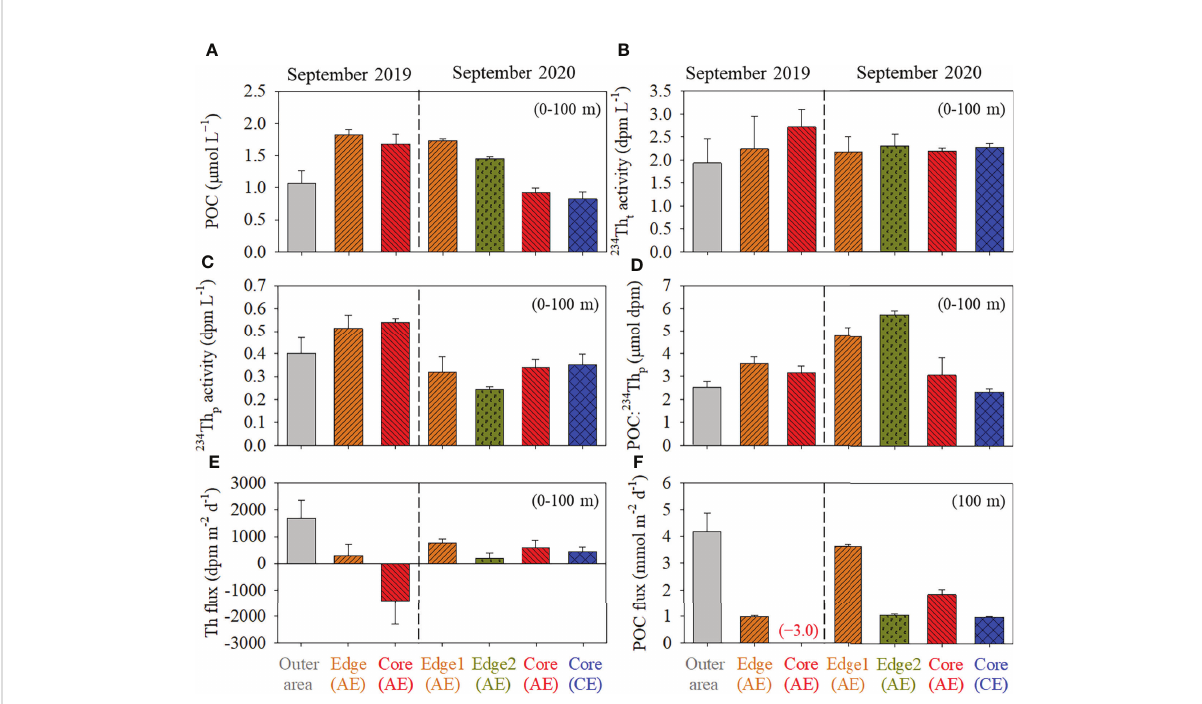
FIGURE 4 The concentrations of (A) POC, (B) 234 Th t , (C) 234 Th p , (D) POC: 234 Th p , (E) 234 Th fl ux, and (F) POC fl ux in the upper 100 m layer at the reference site, the edge, the core of the anticyclonic eddy, and the core of the cyclonic eddy in the tropical northwest Paci fi c in